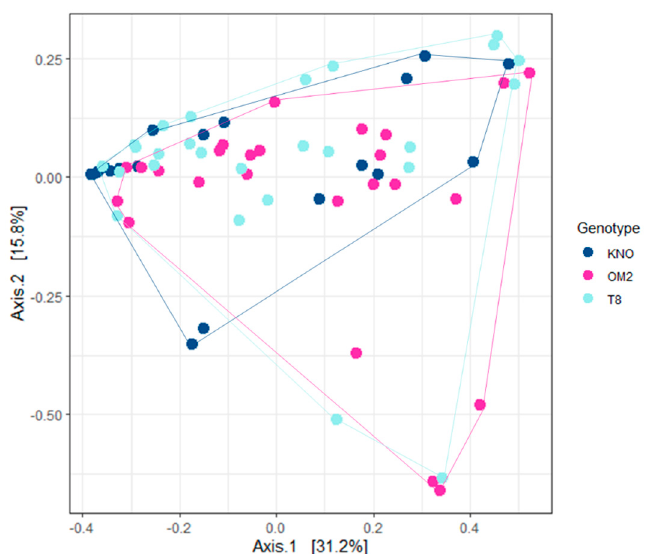
Figure 7. PCA of the gut microbial communities of recipients using weighted UniFrac distance for genotype. Colors indicate genotype.